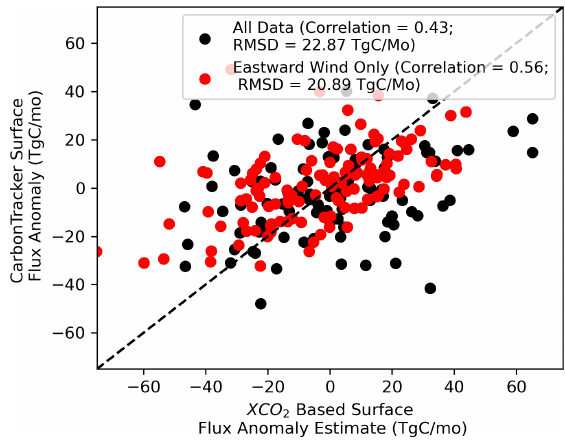
Figure 5. CarbonTracker XCO 2 flux anomaly estimation over- all performance in the Western US considering a spatially expan- sive target domain (latitude = 33–49 ◦ N, longitude = 124–104 ◦ W as shown in Fig. 2). Relationship between CarbonTracker surface CO 2 flux anomaly outputs and mass-balance-based surface CO 2 flux anomaly estimates based on CarbonTracker XCO 2 anomaly enhancements. Only CarbonTracker data were used here where its XCO 2 , wind velocity, and pressure outputs were used to estimate surface CO 2 flux anomalies with Eq. (1), which are compared to CarbonTracker total surface CO 2 flux anomaly outputs. Legend shows correlations and root-mean-square differences between the CarbonTracker XCO 2 -based flux anomaly estimates (Eq. 1) and CarbonTracker surface CO 2 flux anomaly outputs. “Eastward Wind Only” includes only data pairs when the incoming wind direction from the Pacific Ocean is between − 60 and 60 ◦ angles from east- ward reference